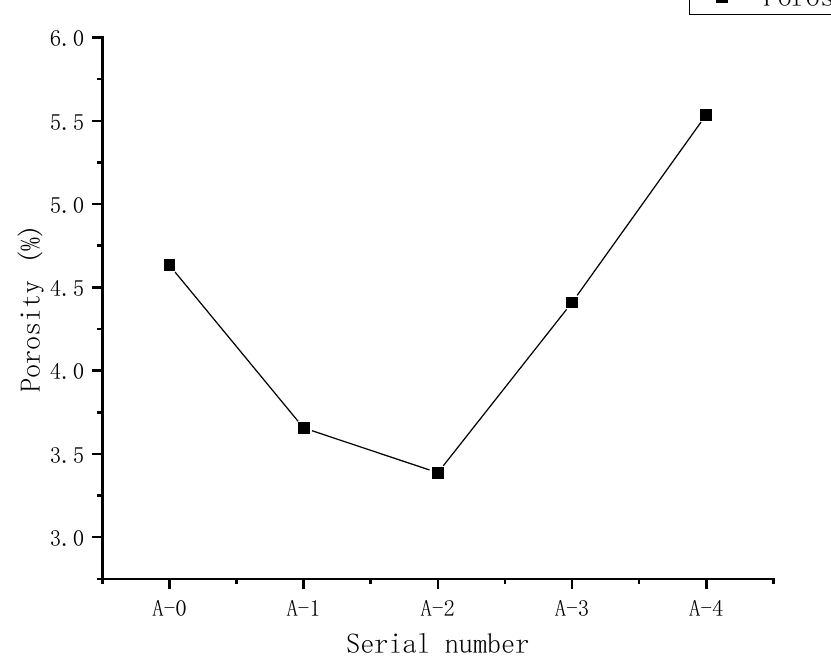
Figure 11. Twenty-eight-day porosity of RPC samples with different numbers.